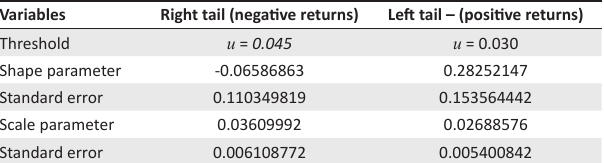
FIGURE 4: (a) Probability, (b) quantile, (c) return level and (d) density plots for the left tail (positive returns, representing the gains). TABLE 2: Parameter estimation using maximum likelihood estimate method for J580 Index. Variables Right tail (negative returns)